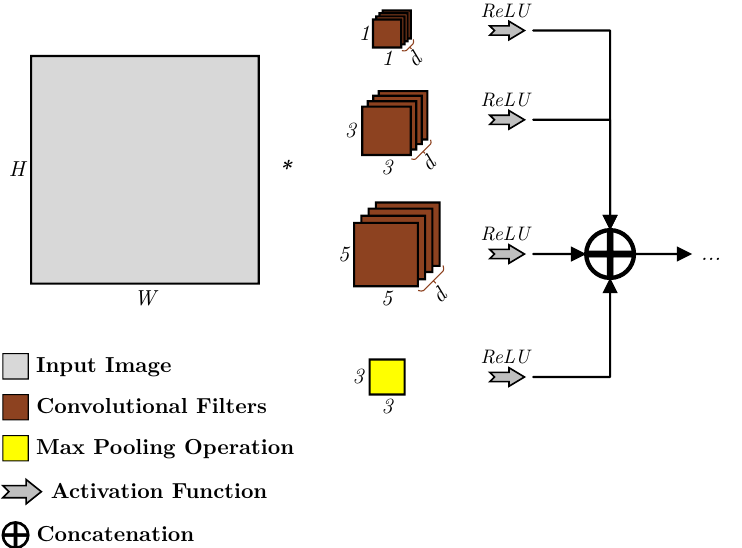
Figure 1. An overview of an Inception v1 layer which consists of parallel convolutional kernels and a pooling layer [5].